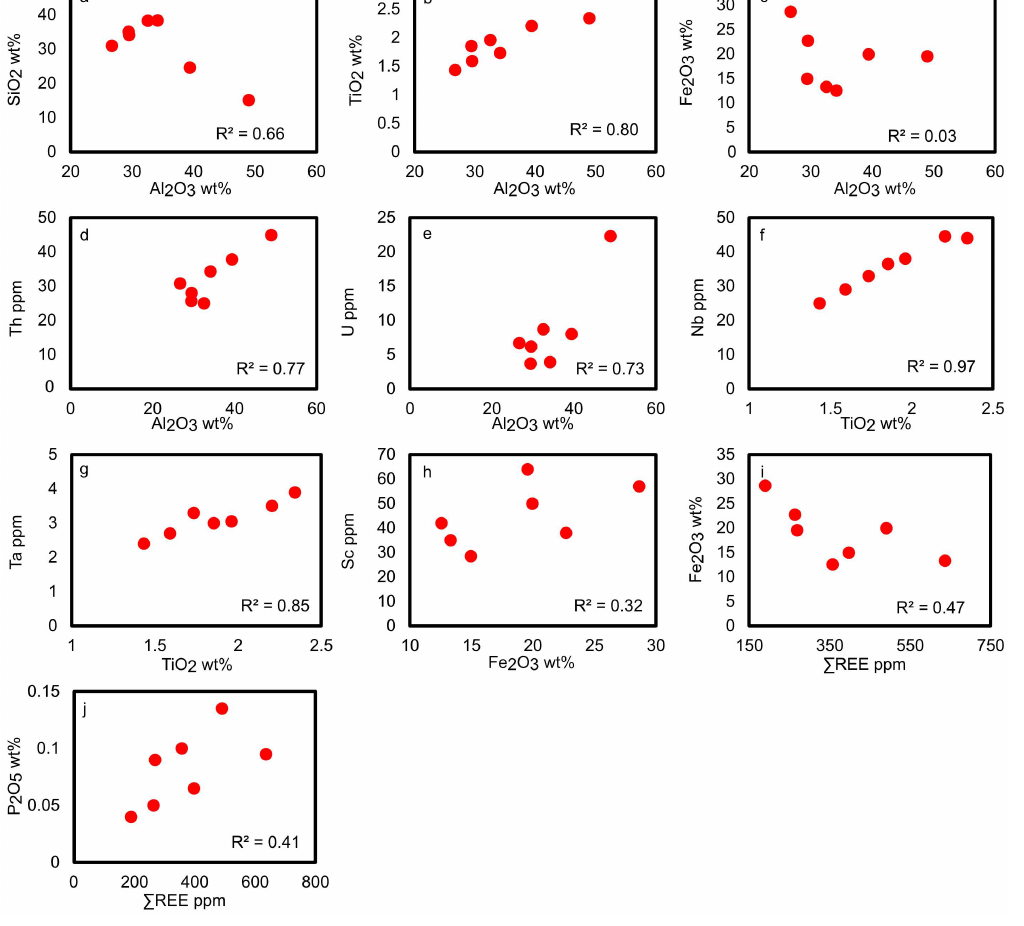
Figure 3. Selected Harker-type diagrams for major, minor and trace elements in the analyzed bauxitic samples. ( A ) Al 2 O 3 vs. SiO 2 , ( B ) Al 2 O 3 vs. TiO 2 , ( C ) Al 2 O 3 vs. Fe 2 O 3 , ( D ) Al 2 O 3 vs. Th, ( E ) Al 2 O 3 vs. U, ( F ) TiO 2 vs. Nb, ( G ) TiO 2 vs. Ta, ( H ) Fe 2 O 3 vs. Sc, ( I ) ∑REE vs. Fe 2 O 3 , ( J ) ∑REE vs. P 2 O 5 .